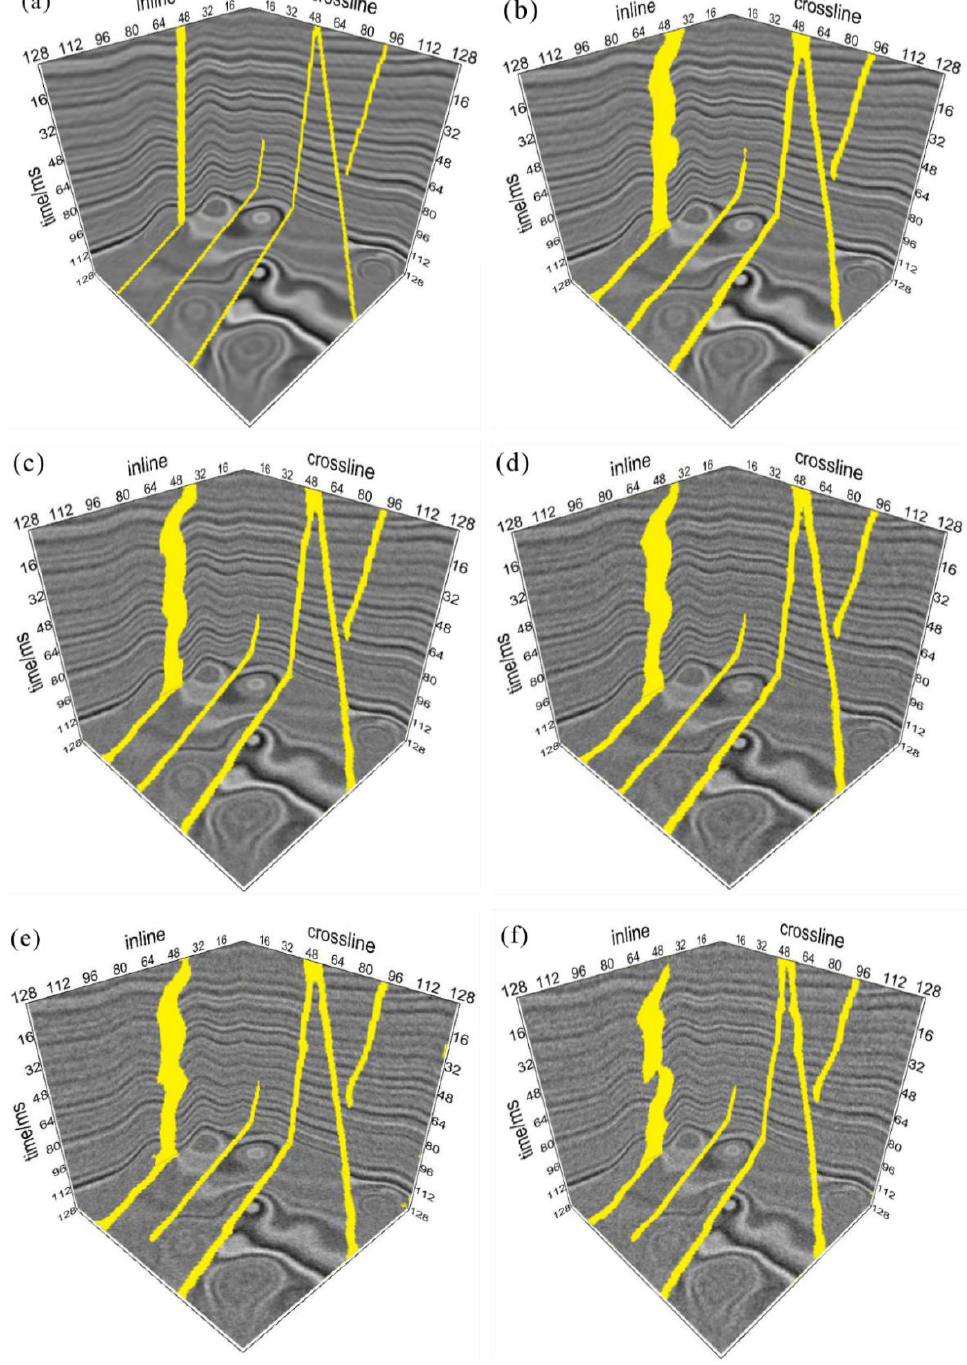
Figure 10. Results of SE-UNet model predicting different SNR data. ( a ) Noise-free simulated seismic data and fault labels; ( b ) simulated seismic data and fault prediction results with SNR of 20 db; ( c ) simulated seismic data and fault prediction results with SNR of 10 db; ( d ) simulated seismic data and fault prediction results with SNR of 7 db; ( e ) simulated seismic data and fault prediction results with SNR of 6 db; ( f ) simulated seismic data and fault prediction results with SNR of 5